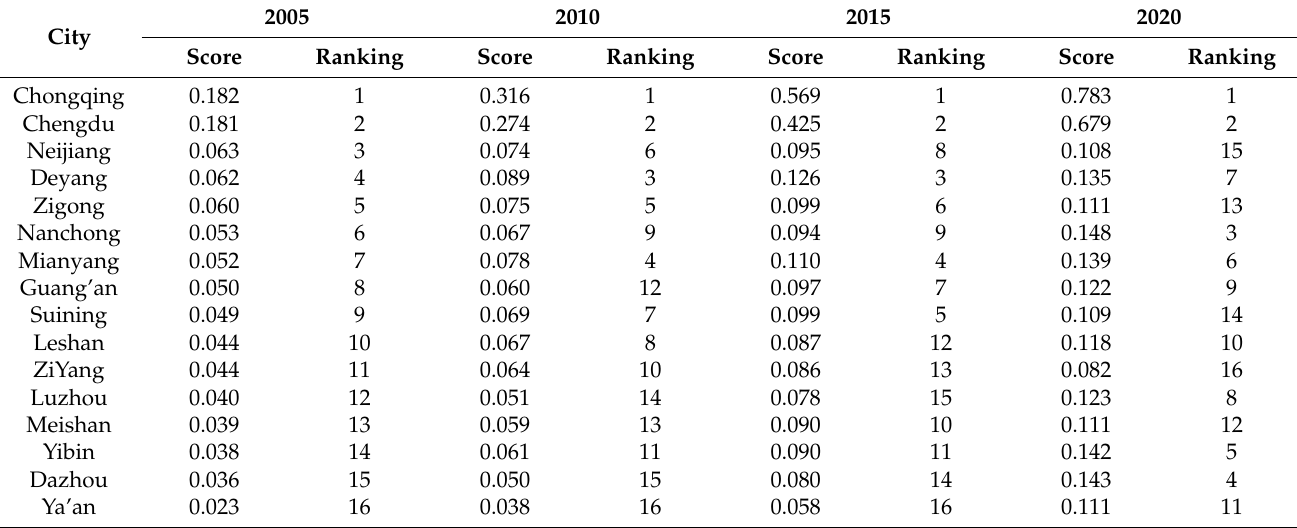
Table 6. Index of economic–social development level of cities in the Chengdu–Chongqing urban agglomeration,